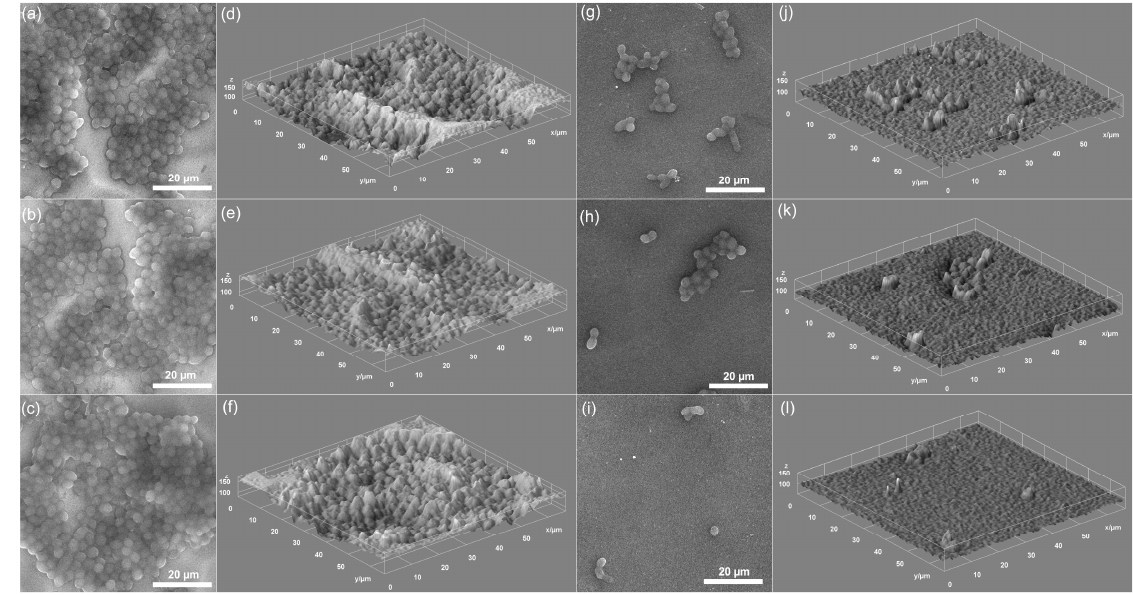
Figure 10. Two-dimensional (2D) SEM images and 3D representation of Candida albicans American Type Culture Collection (ATCC) 10231 cell development on HAp ( a – f ) and 10Ce-HAp ( g – l ) coatings at different time intervals of incubation 24 h ( a , d , g , j ) 48 h ( b , e , h , k ), and 72 h ( c , f , i , l ).